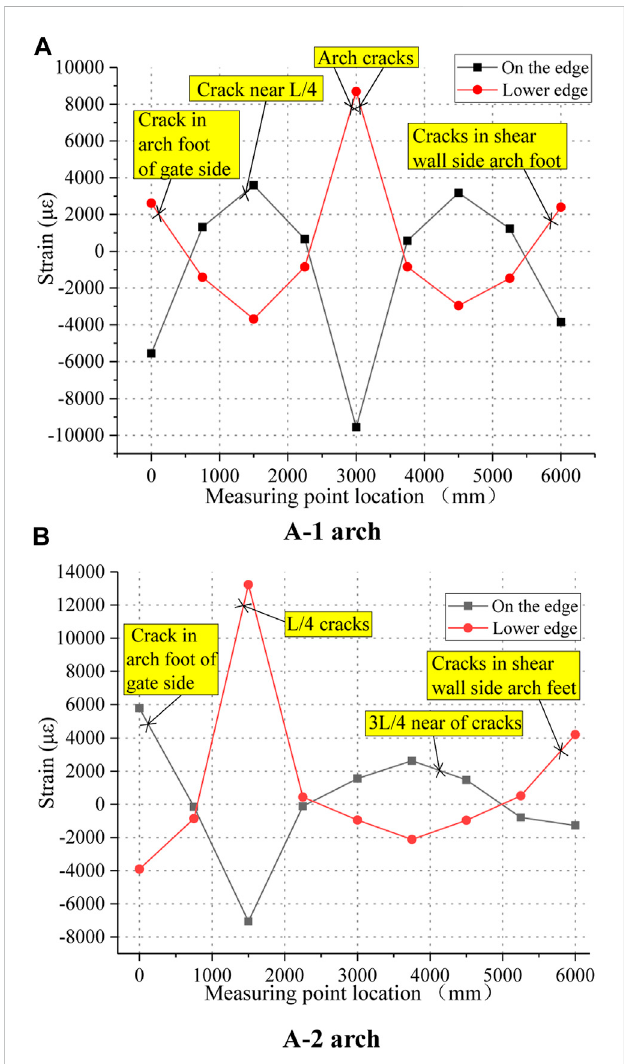
FIGURE 11 Strain and crack distribution of concrete in the tube under ultimate load: (A) A-1 arch; (B) A-2